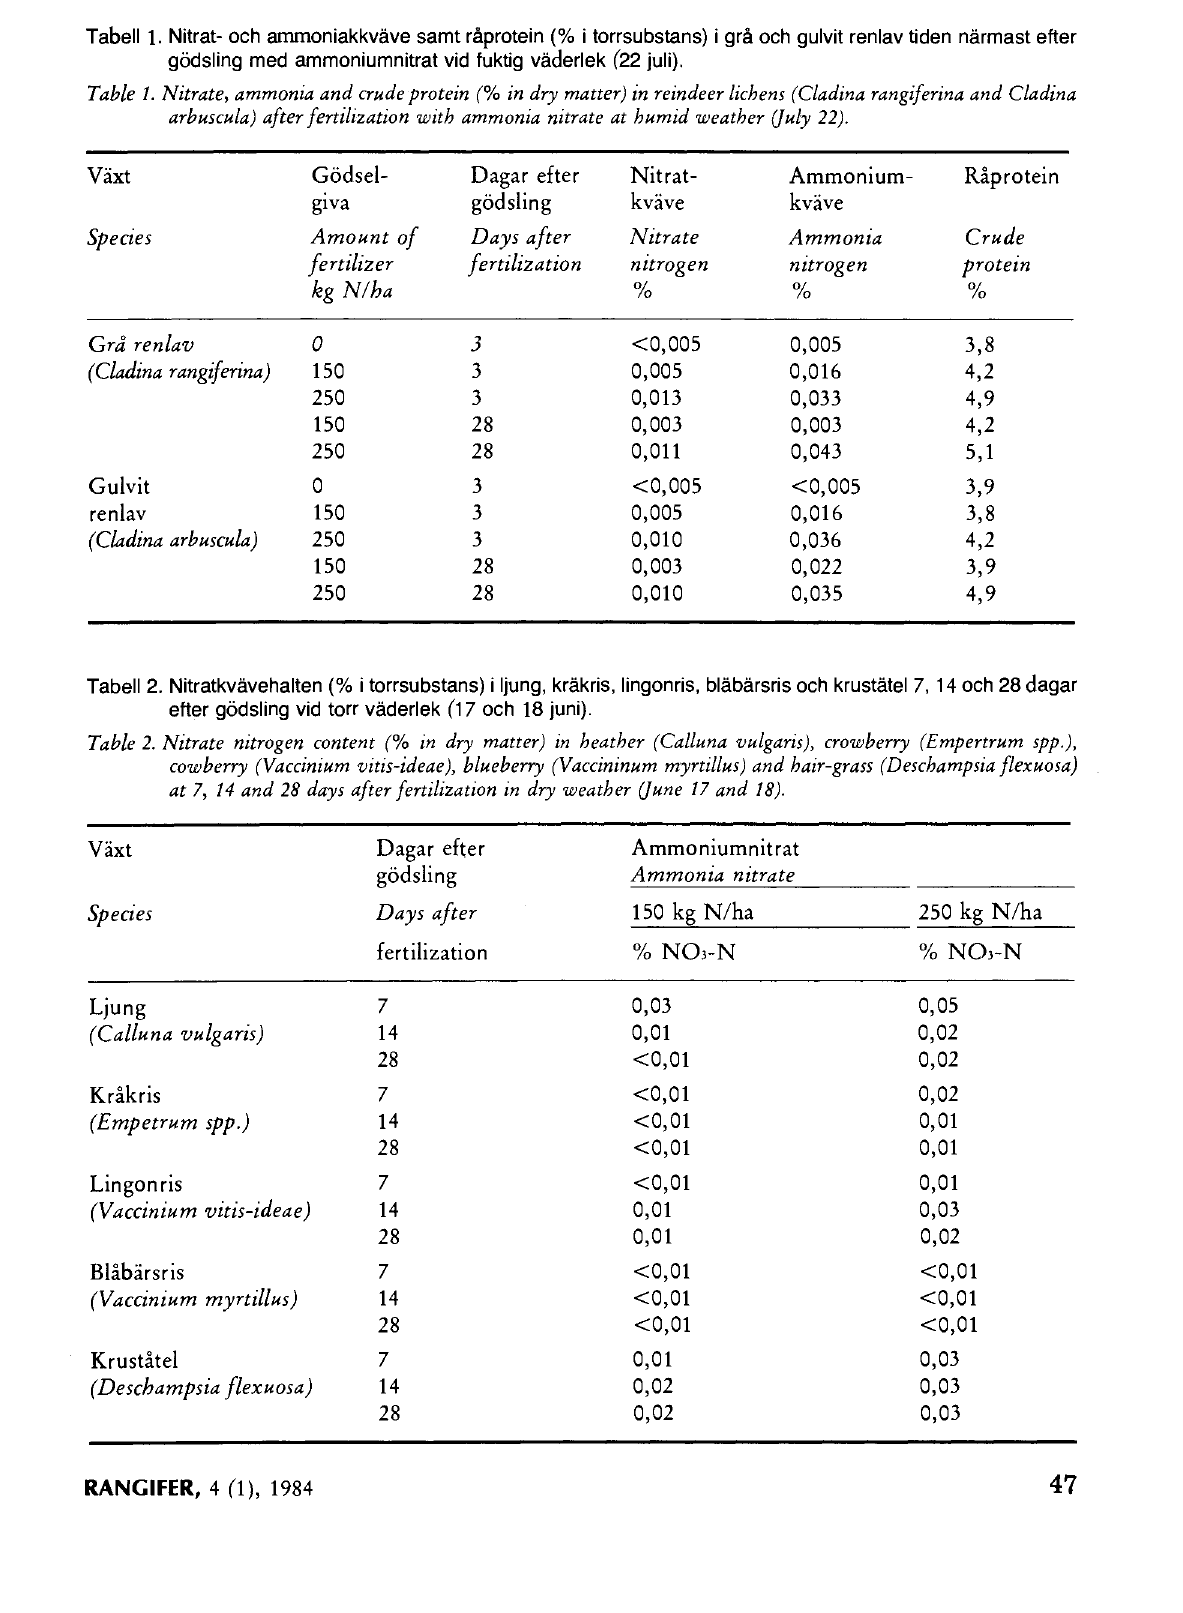
Vaxt Gödsel- Dagar efter Nitrat- Ammonium- giva gödsling kväve Species Amount of Days after Nitrate fertilization